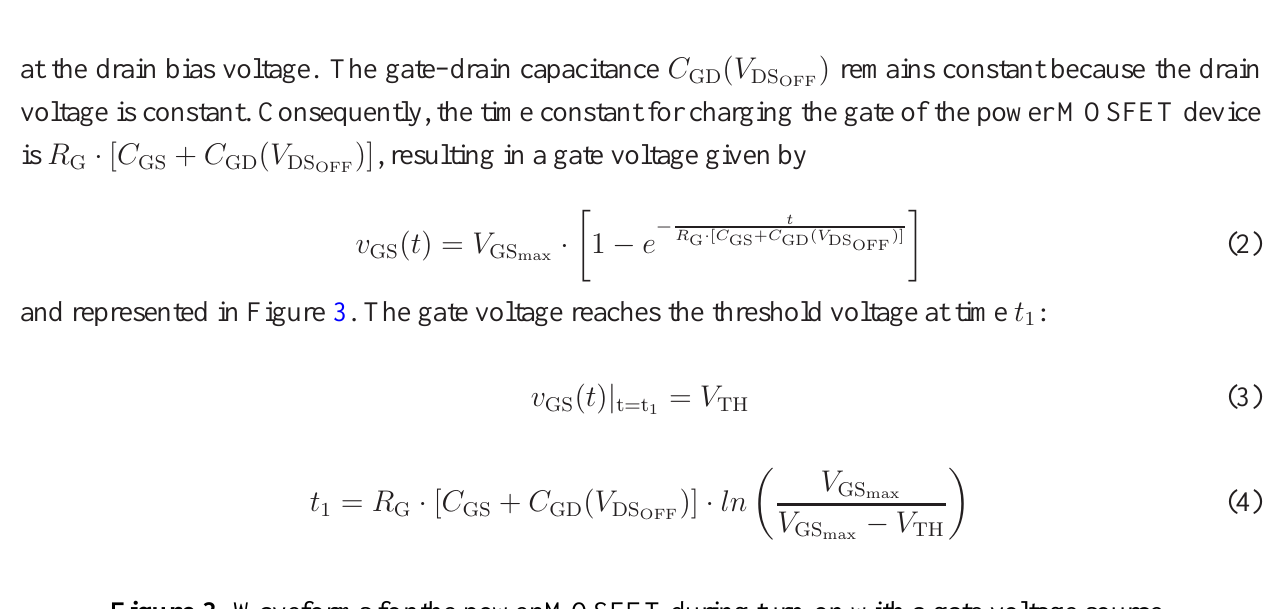
Figure 3. Waveforms for the power MOSFET during turn-on with a gate voltage